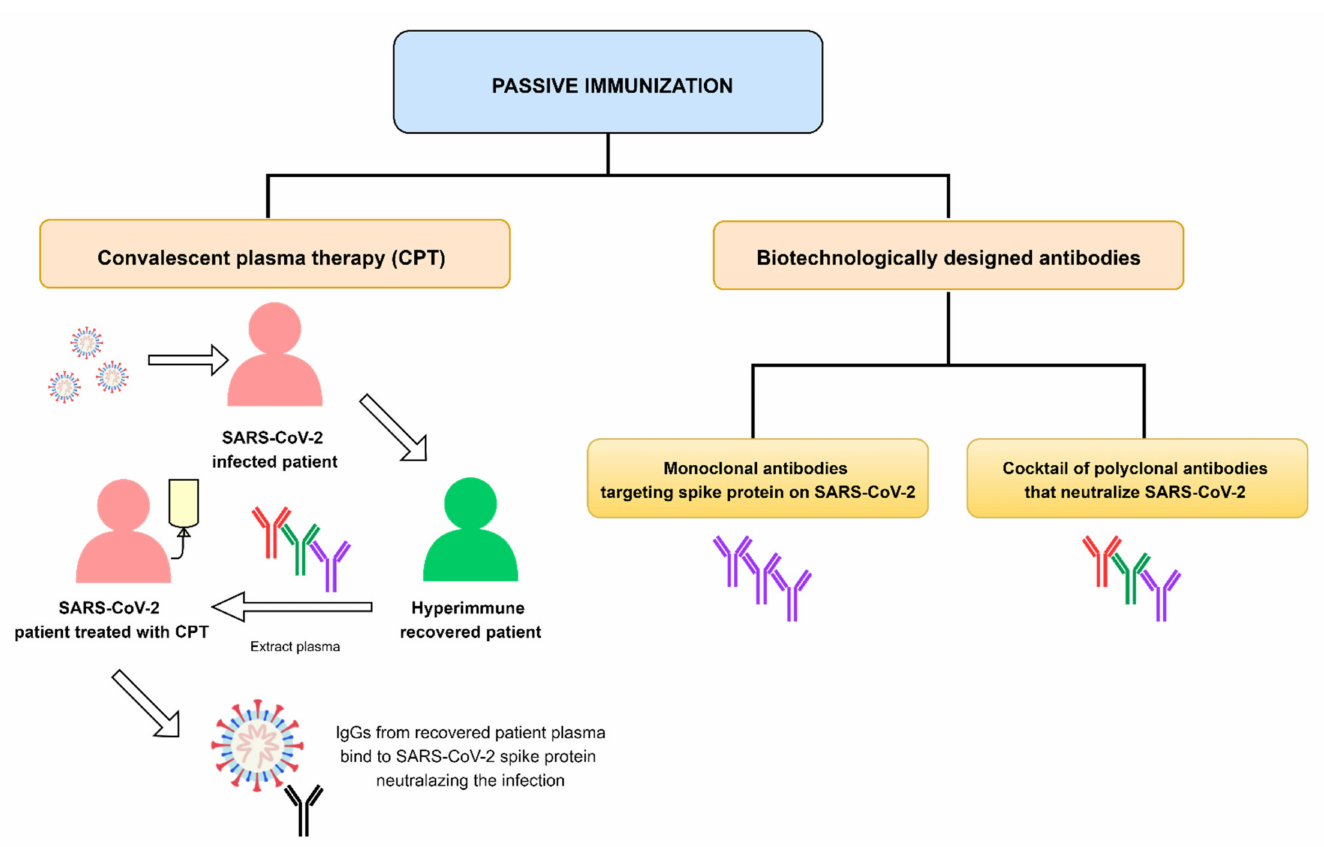
Figure 1. Different strategies to guarantee passive immunization using